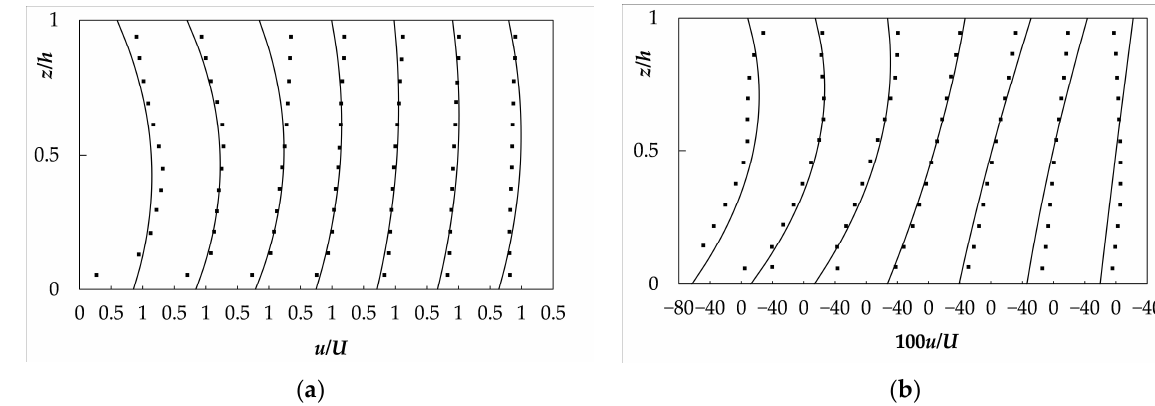
Figure 3. S90 cross section stream-wise velocities ( a ) and transversal velocities ( b ). Solid square points represent the experimental results, and the solid lines represent the simulation. From left to right, the transversal locations are 0.10B, 0.17B, 0.27B, 0.46B, 0.65B, 0.79B, and 0.88B from the left bank.